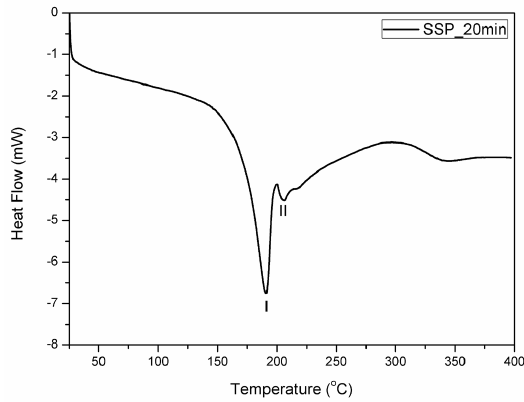
Figure 7. DSC curve of the milled SSP_20 min fertilizer sample.